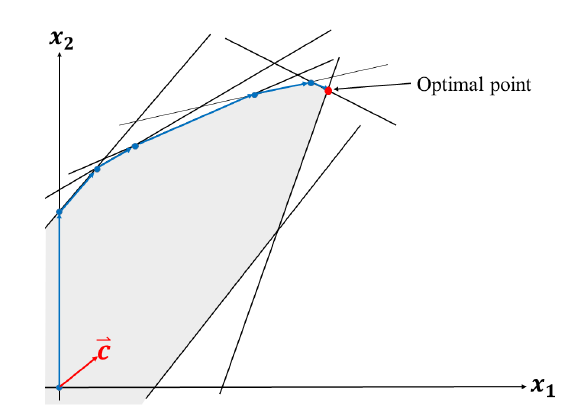
Figure 1. Simplex method for SNAR (artificial-free simplex algorithm based on the non-acute constraint relaxation).